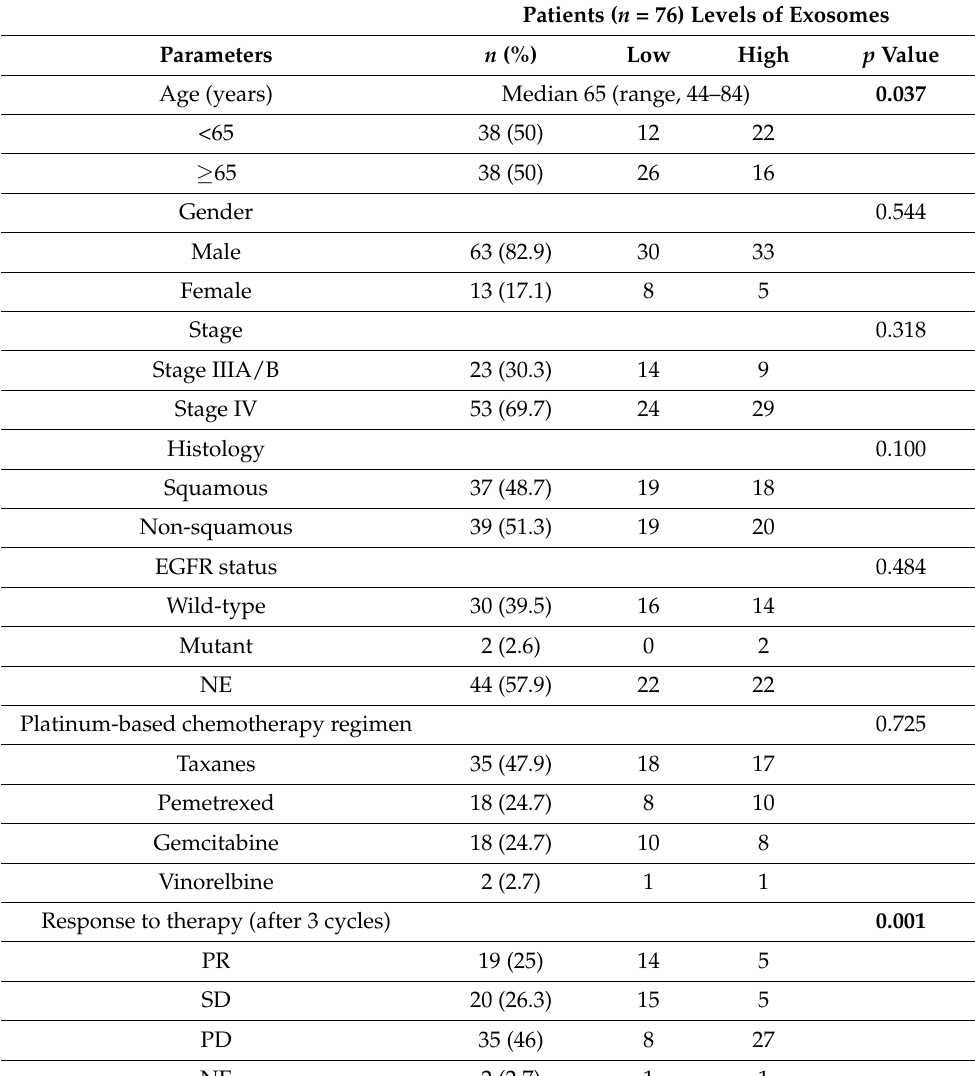
Table 1. The patients’ clinicopathological